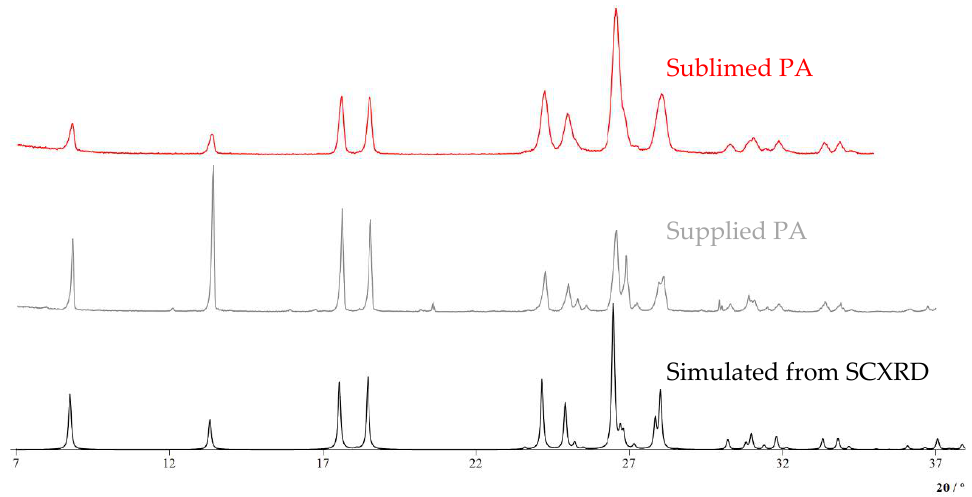
Figure 2. Comparison of X-ray diffraction patterns obtained at 293 ± 2 K for: the sublimed PA (red), the PA as supplied (gray), and the pattern estimated from the SCXRD structure found in the literature [11] (black). All the diffractograms were normalized to the peak of highest intensity ( I n ) and plotted using EasyGraphII [19].